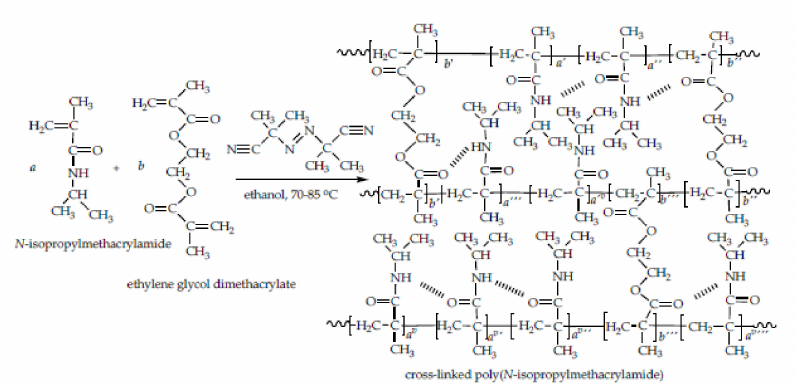
Figure 1. The chemical reaction of the cross-linked poly( N -isopropylmethacrylamide) (p( N iPMAm)) homopolymer network synthesis with an indication of the potential intramolecular hydrogen bonds